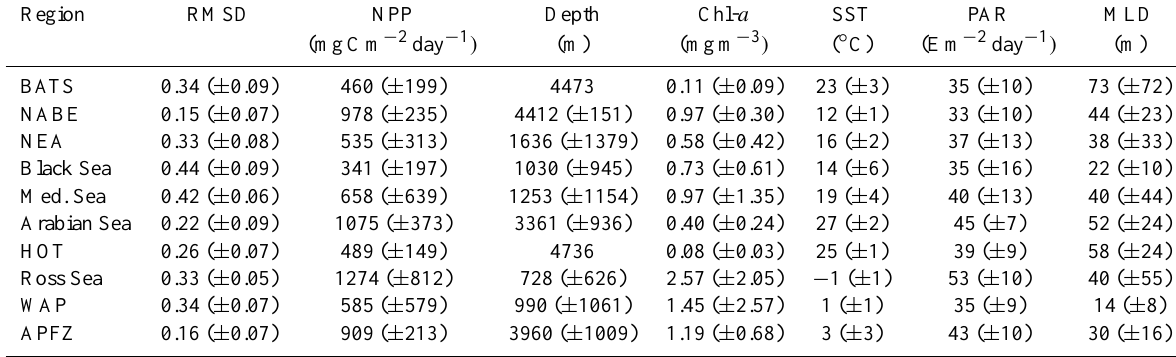
Table 4. Mean RMSD (model skill), depth, in situ NPP, and input data ( ± standard deviation) for each of the ten regions. Region RMSD NPP Depth Chl- a SST PAR (mgCm − 2 day − 1 ) BATS 0.34 ( ± 0.09)